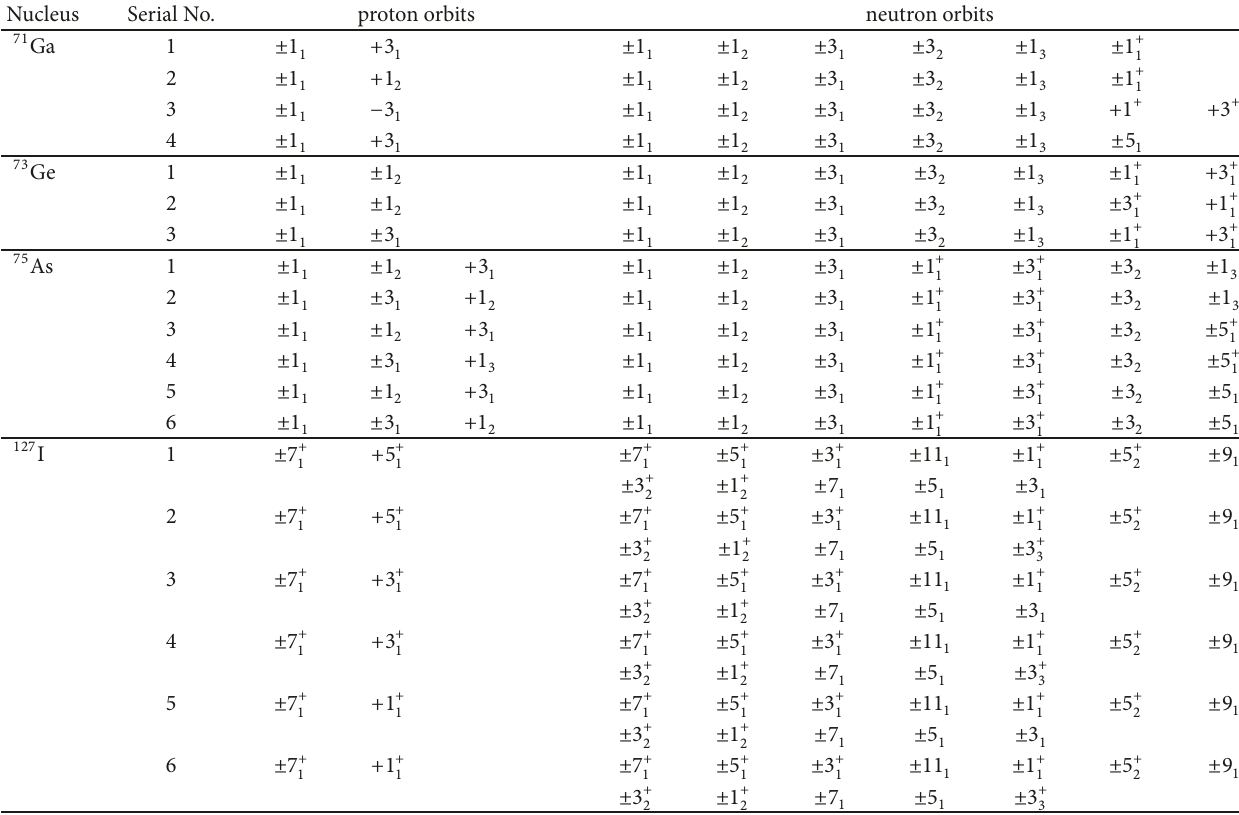
Table 2: 2𝑘 values of the occupied proton and neutron single particle deformed orbits of the HF intrinsic states used in the calculation for each nucleus. The second column gives the serial no. of the HF intrinsic states used. All the 2𝑘 values are of negative parity unless explicitly shown. The (+) , (−) , or (±) sign before the 2𝑘 values implies that either the time-like, time-reversed, or both orbits are occupied. In columns 3 and 4, 3 1 means the first 3/2 − HF deformed sp orbit, 3 2 means the second 3/2 − deformed HF orbit, and so on (see also Figure 2). Detailed information regarding the structure each of the deformed HF sp orbits, their energies, and the parentage of each of the HF intrinsic state in the Φ 퐽 states (e.g., the linear combination of 𝜙 퐽 푀퐾 obtained in the band mixing diagonalisation) can be obtained from the